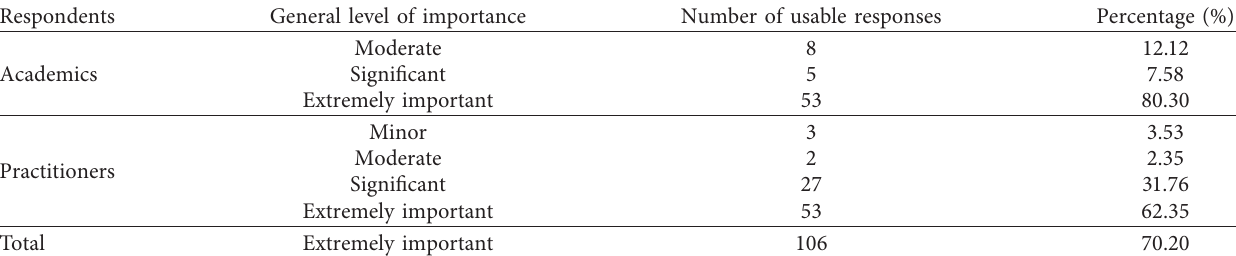
Table 4: Importance of the influence of coopetition on international contractors.